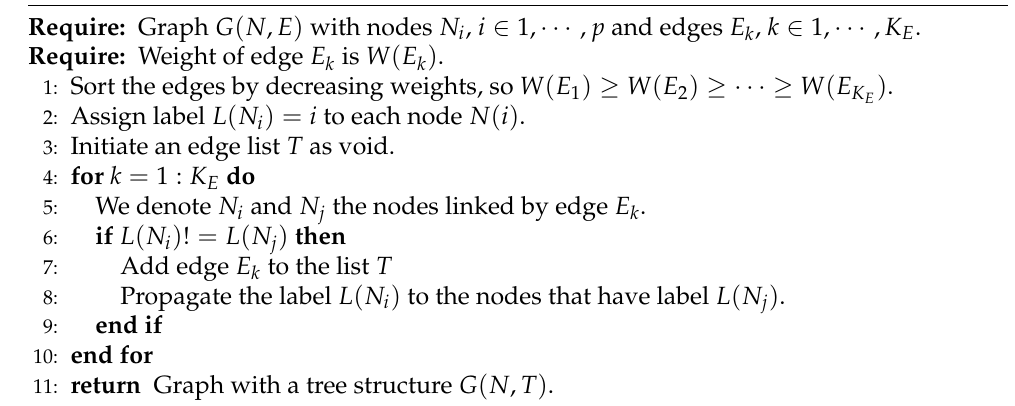
Algorithm 1 Maximum spanning tree